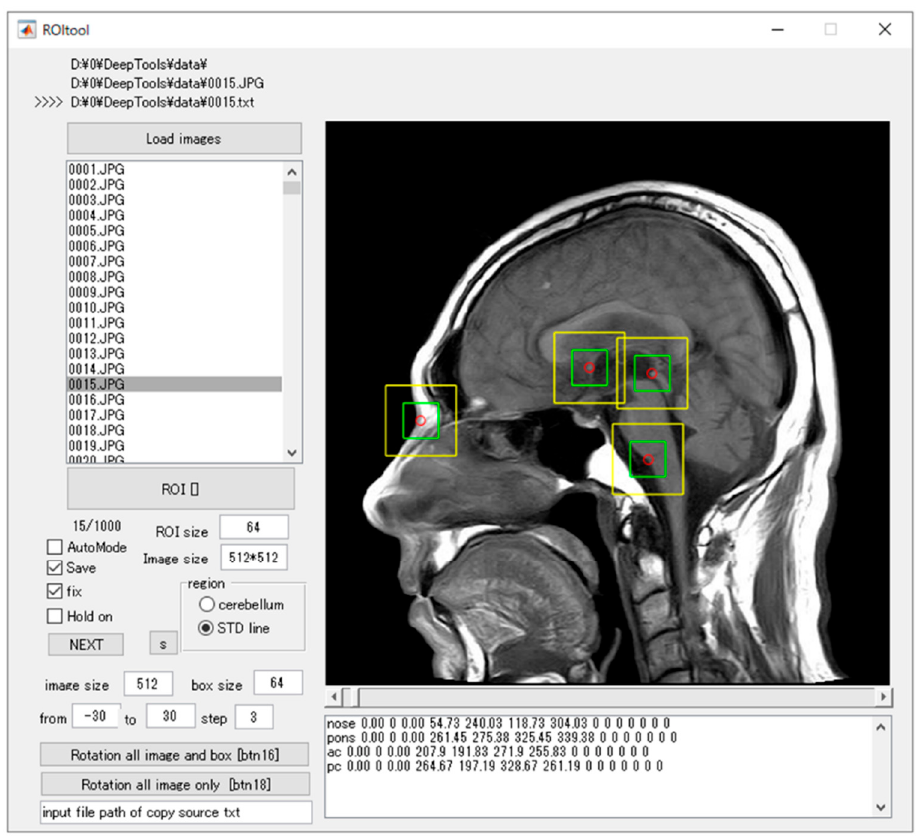
Figure 1. The software for training outlined ROIs over the noteworthy anatomical characteristics. The red circle is the center of the target anatomy, the yellow bounding boxes are the ROIs measuring 64 × 64 pixels, and the green bounding boxes are the ROIs measuring 32 × 32 pixels.